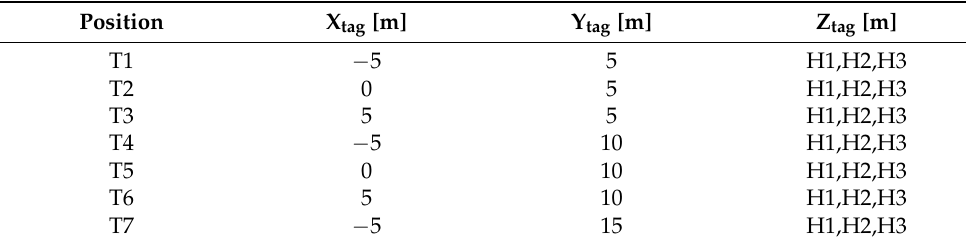
Table 3. Tag positions in the UGV’s coordinate